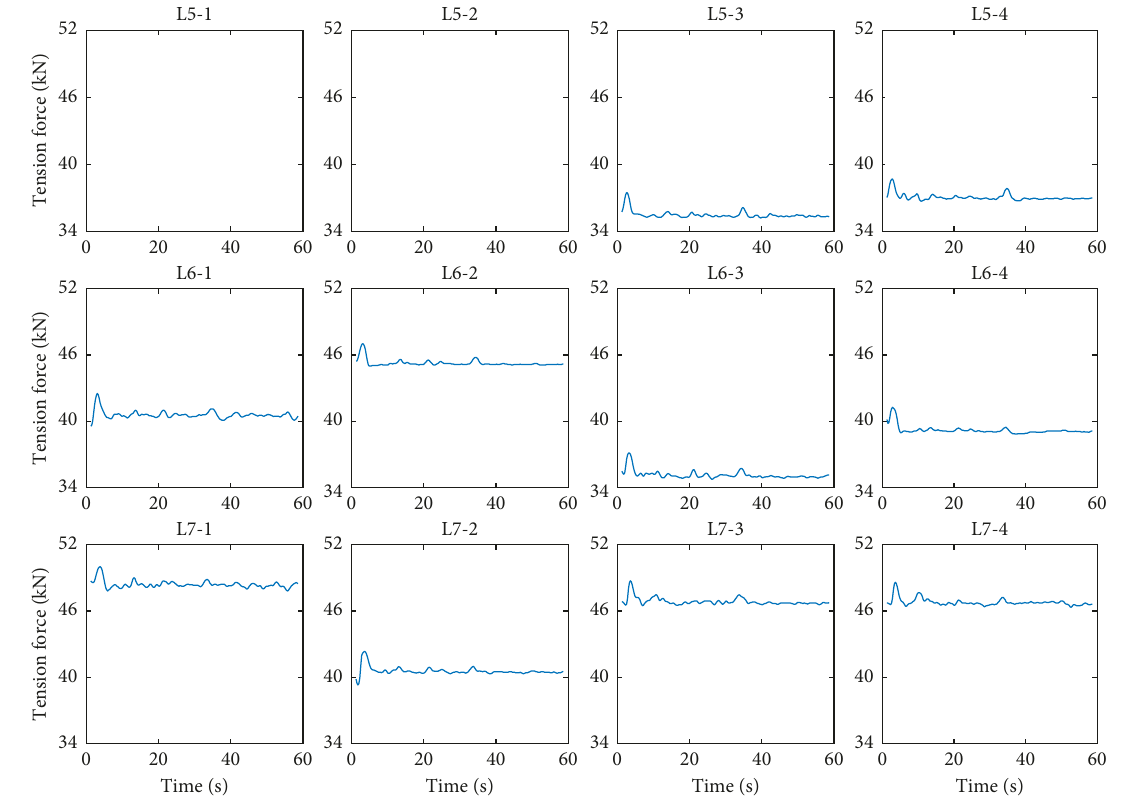
Figure 14: Cable tension force